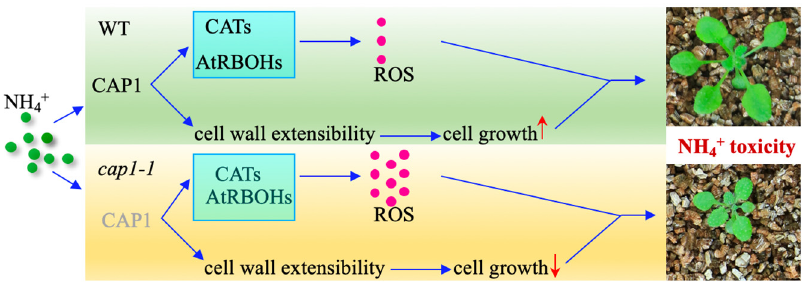
Figure 7. A proposed model for the role of CAP1 in shoot growth in response to NH 4+ stress. Under NH 4+ stress, CAP1 regulates the expression of RBOH, CAT, and cell expansion-related genes to maintain ROS homeostasis and cell wall expansion to allow shoot growth. Deficiency of CAP1 enhances the downregulation of cell expansion-related genes and the accumulation of ROS in shoots under NH 4+ stress, which results in shoot growth inhibition.